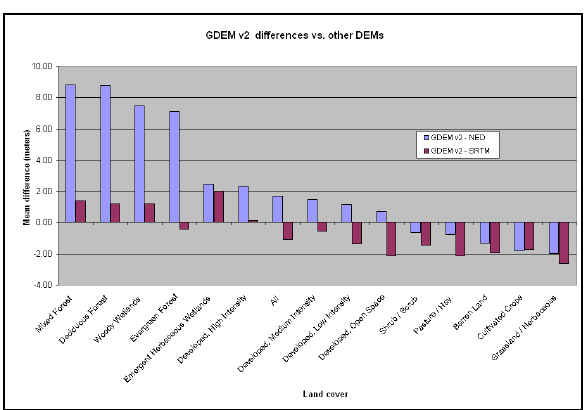
Figure 5. GDEM v2, NED, and SRTM mean errors by aggregated land cover class.